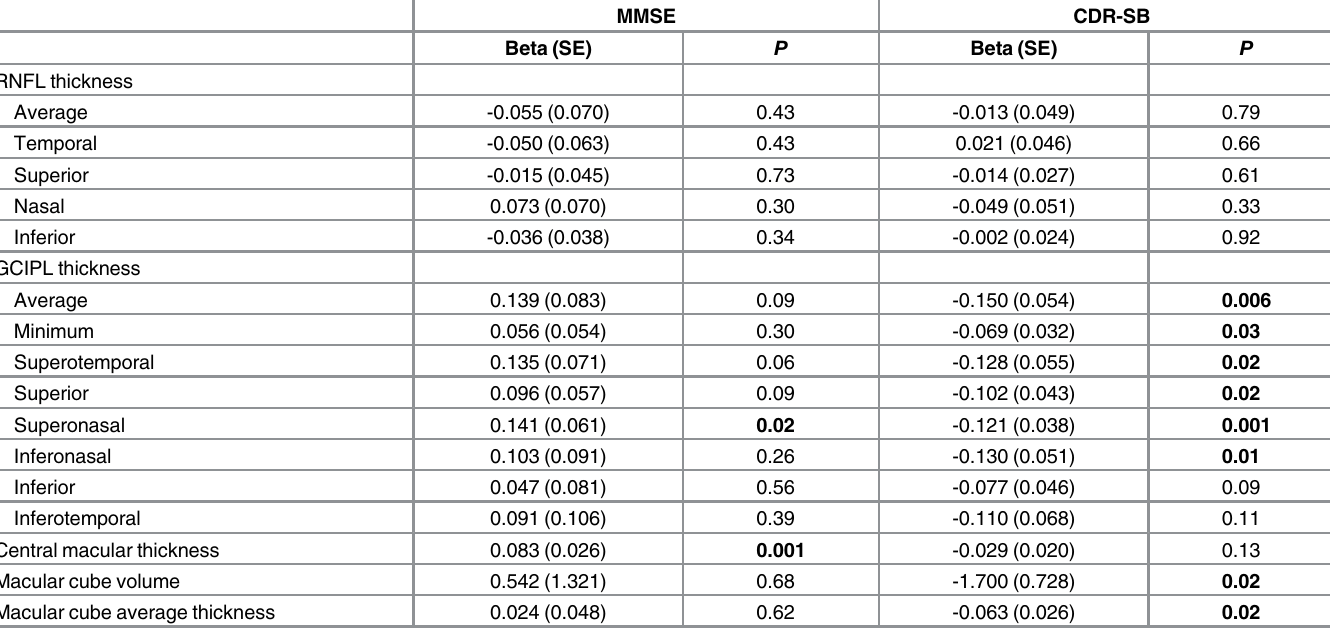
Table 5. The impact of the thicknesses of retinal nerve fiber layer (RNFL) and ganglion cell inner plexiform layer (GCIPL) at baseline on the changes of MMSE and CDR-SB at 2 years in the patients with mild cognitive impairment or Alzheimer ’ s